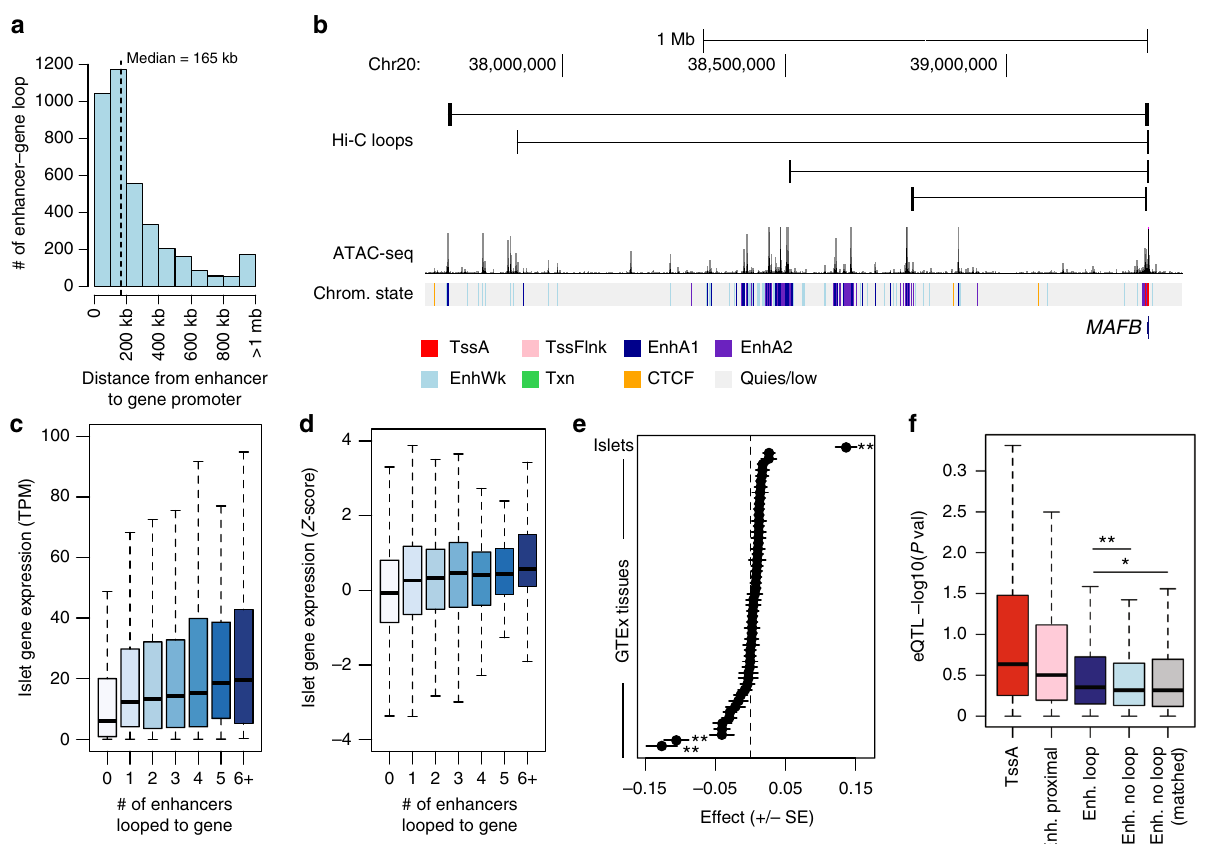
Fig. 2 Islet enhancer regulation of distal target gene expression. a Enhancers looped to gene promoters on average over a 165 kb distance, including >10% over 500 kb. b Distal islet enhancers formed chromatin loops with the MAFB promoter, including two over 1 MB. c Genes with increasing numbers of chromatin loops with islet enhancers had increased expression level in islets, with the highest expression among genes with six or more looped enhancers. d Genes with increasing numbers of chromatin loops with islet enhancers in had increased relative expression level in islets Z -score normalized across 53 GTEx tissues. e The number of chromatin loops with islet enhancers was a signi fi cant predictor of relative islet gene expression compared to relative gene expression in 53 other tissues in GTEx. Values represent effect size and SE from the linear model. ** P < 0.0001. f Gene expression QTL P -values for genetic variants in gene promoters (TssA; red), enhancers proximal to gene promoters (Enh. proximal; pink), enhancers in chromatin loops to the gene promoter (Enh. loop; dark blue), and enhancers not in chromatin loops to the gene promoter for both all enhancers (Enh. no-loop; light blue) and enhancers distance- matched with looped genes (Enh. no-loop matched; gray). Variants in enhancer elements had stronger evidence for islet expression QTLs with genes in loops than genes with no loop, even when matched based on distance. Wilcox test * P < 0.05, ** P < 0.0001. Boxplots show the median, and third and fi rst quartiles. Source data are provided as a source data fi